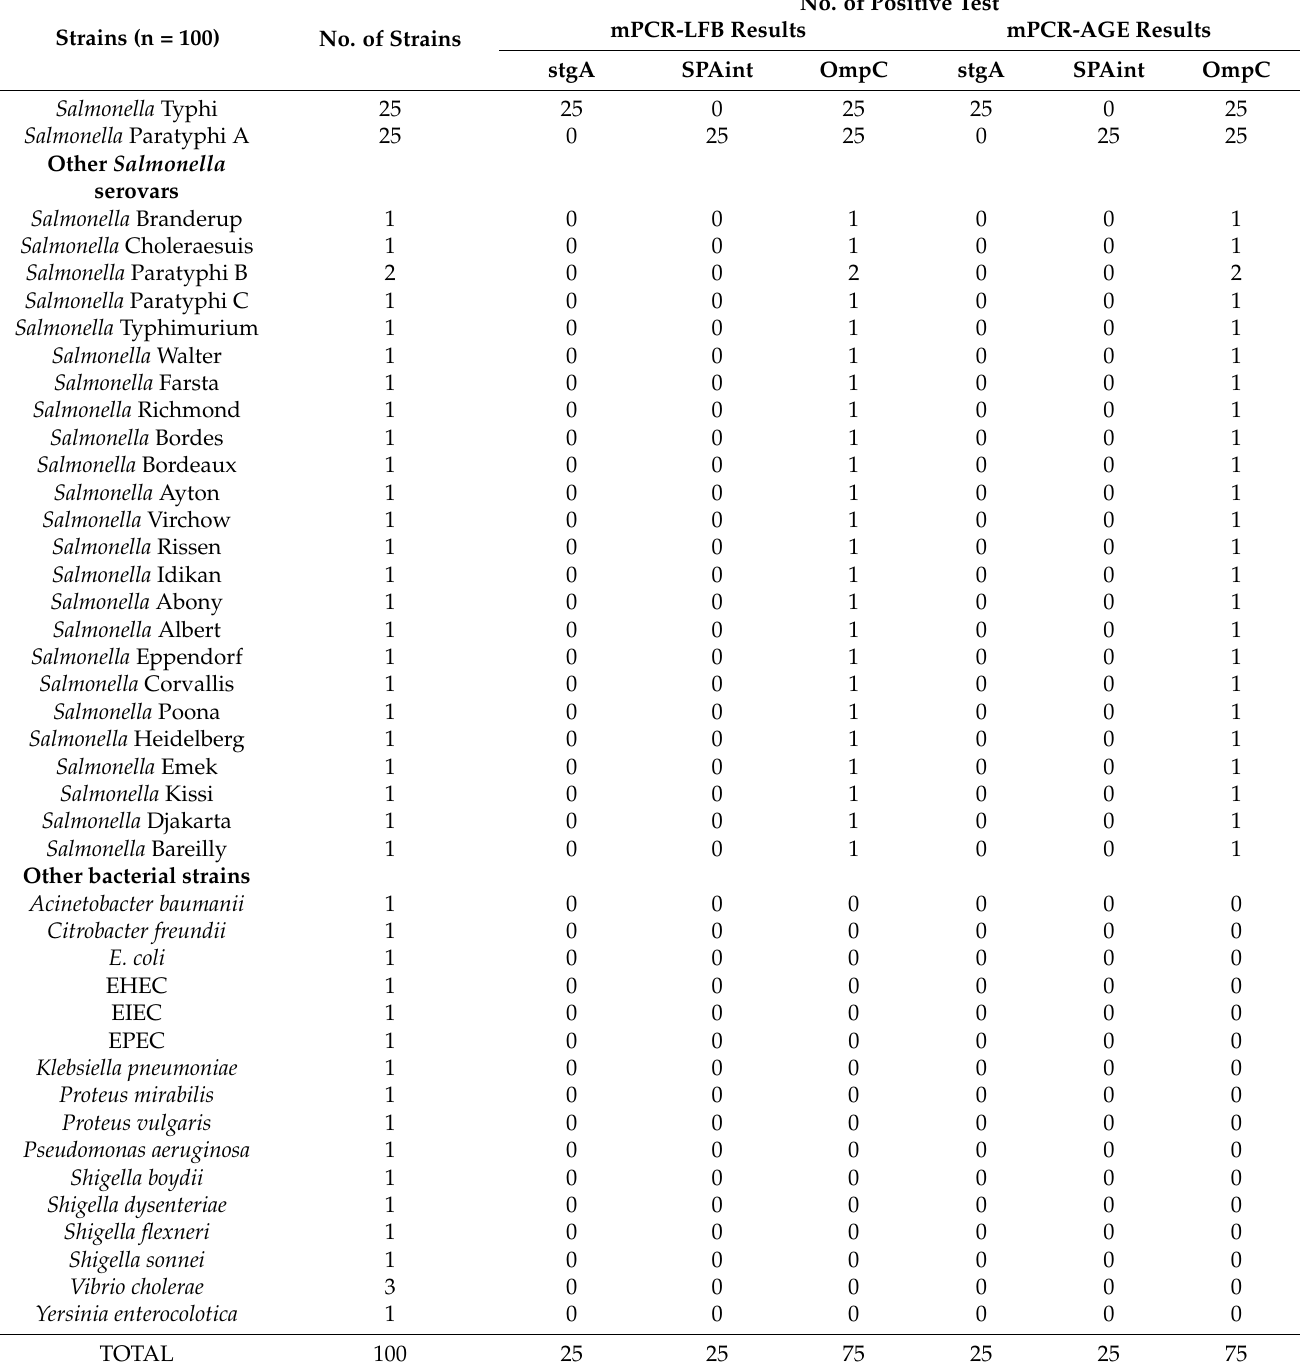
Table 2. Summary of the results of mPCR-LFB and mPCR-agarose gel electrophoresis (mPCR-AGE) using genomic DNA extracted from 100 isolates of different bacteria strains.